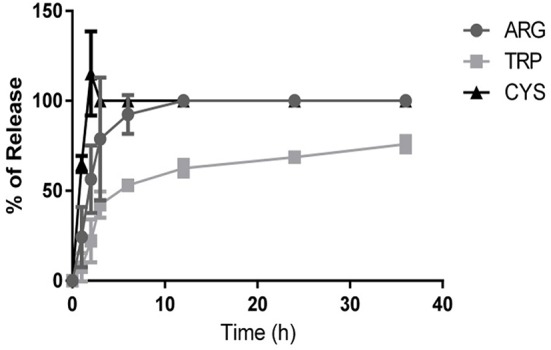
In vitro release of amino acids. Data are presented as means ± SD of three independent experiments. Amino acids tested were l-cysteine (triangles), l-arginine (circles), and l-tryptophan (squares).